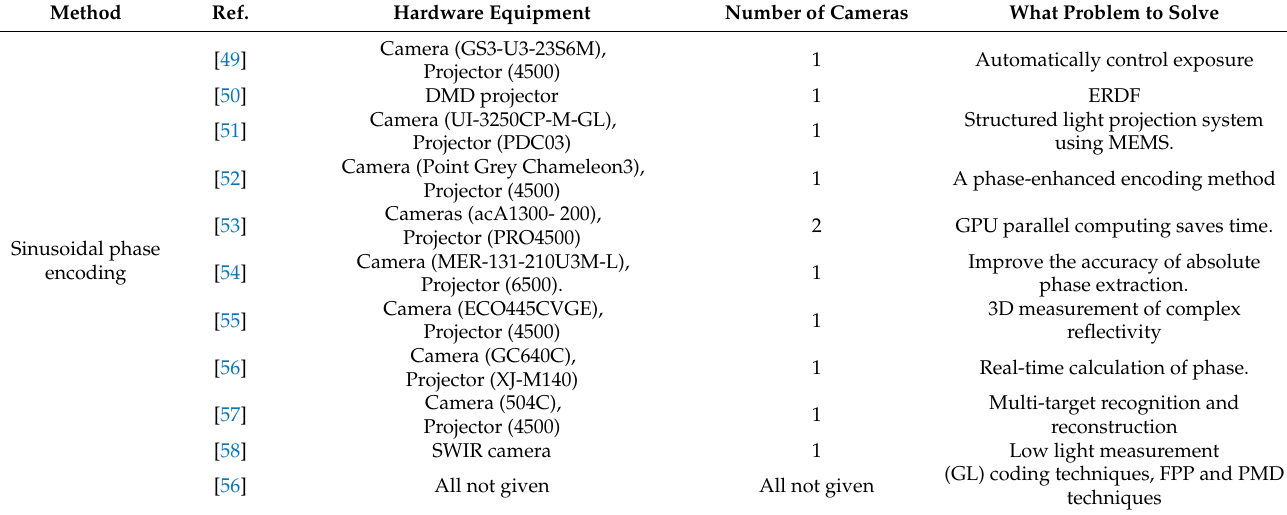
Table 3. Sinusoidal phase